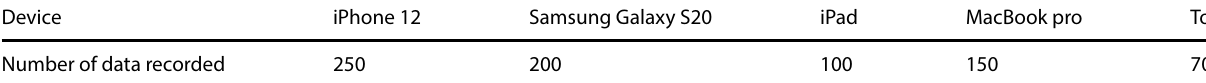
Fig. 5 Steps for collecting recorded samples